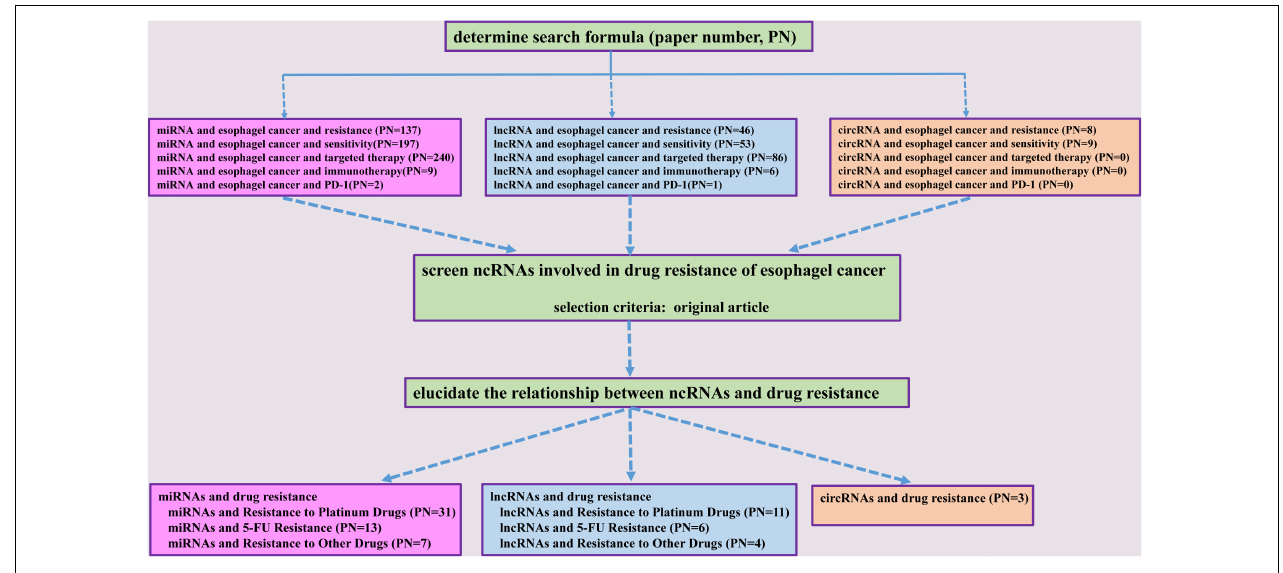
FIGURE 1 | A flow diagram of the study selection